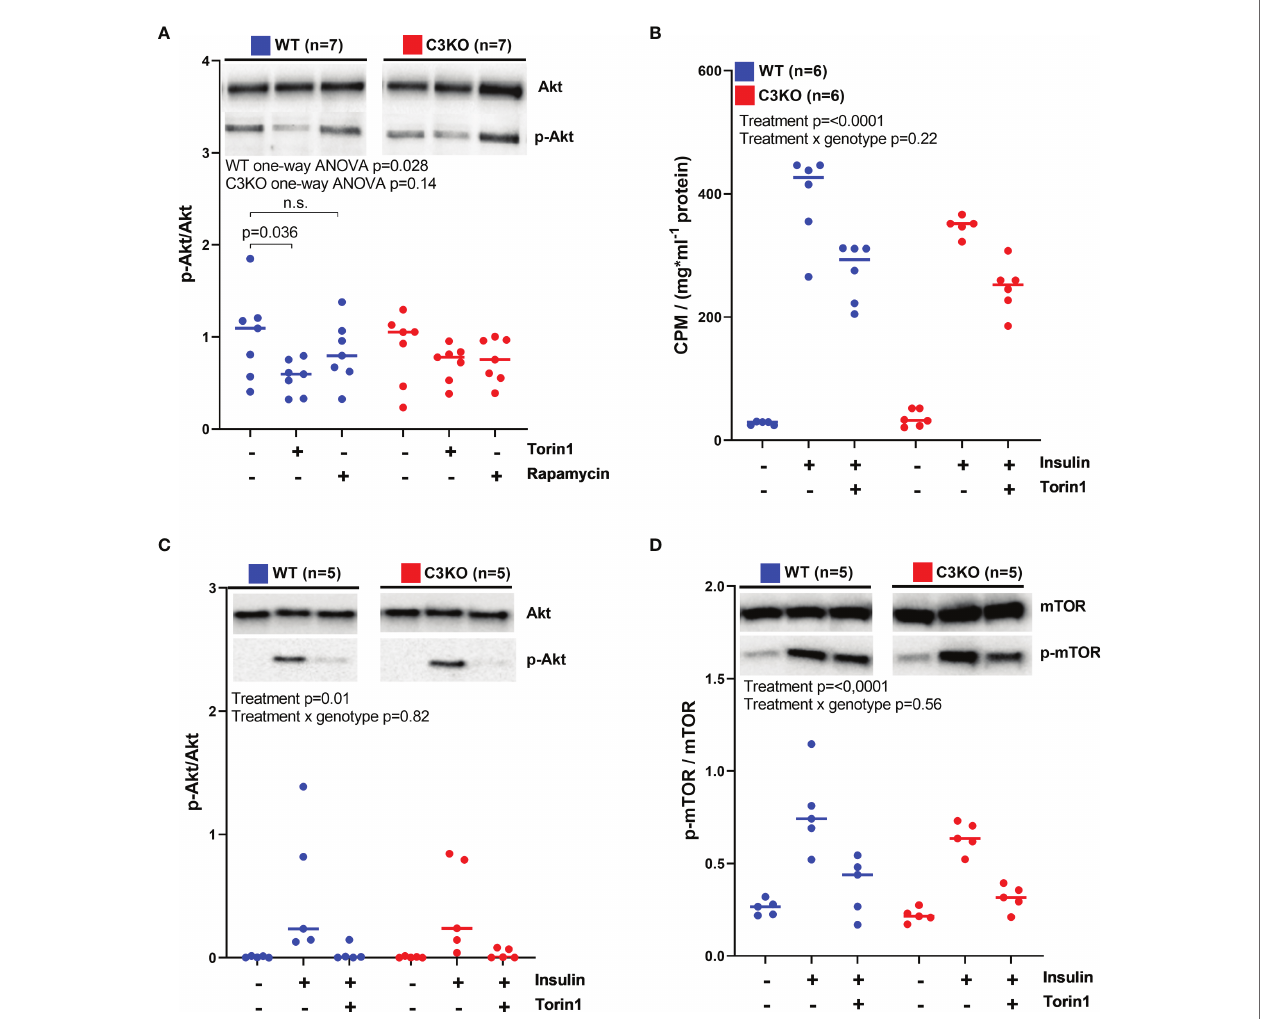
FIGURE 4 | mTOR signaling and glucose uptake in WT and C3KO cardiomyocytes. (A) Activation of Akt was measured in cardiomyocytes from wild type (WT) and complement component 3 knock out (C3KO) that were treated with the mTOR inhibitors, 100 nM Torin1 or 50 nM rapamycin. Activation of Akt was quanti fi ed as a ratio between phosphorylated Akt (p-Akt) over total Akt. Data were analyzed with one-way ANOVA and Dunnett ’ s multiple comparison test for each genotype. (B) 14 C-labelled glucose uptake was characterized in cardiomyocytes from WT and C3KO treated with 100 nM Torin1. (C) Akt and (D) mTOR activation were investigated in cardiomyocytes treated with 100 nM Torin1 with western blotting. Data sets are displayed as scatterplots with median. ns, not signi fi